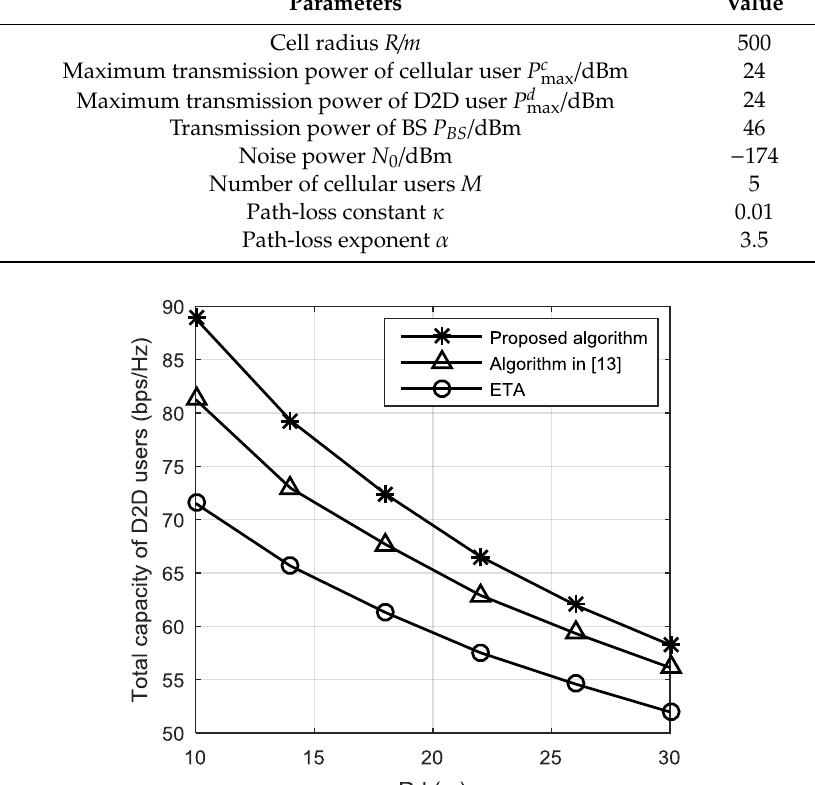
Figure 3. Total capacity of D2D users with different distances between the D2D pair.